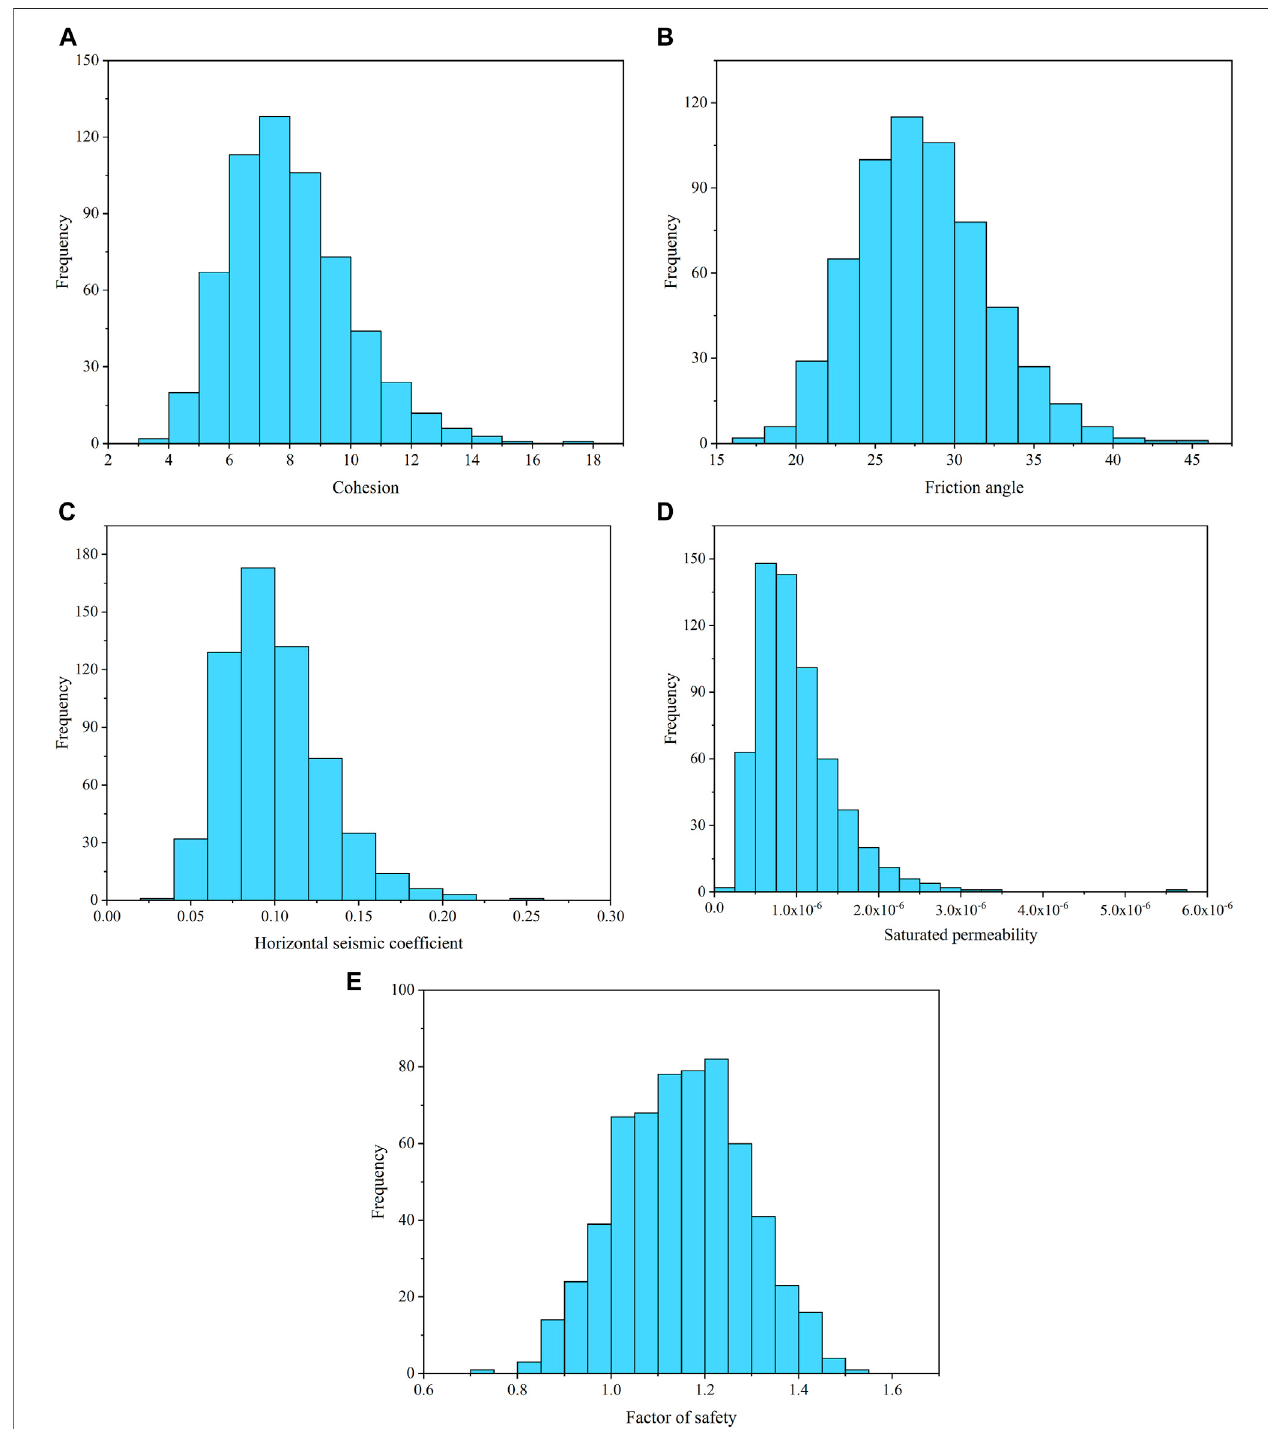
FIGURE 4 | Histogram of the four in fl uential factors and factor of safety: (A) c ; (B) φ ; (C) K h ; (D) k s ; (E) FS.